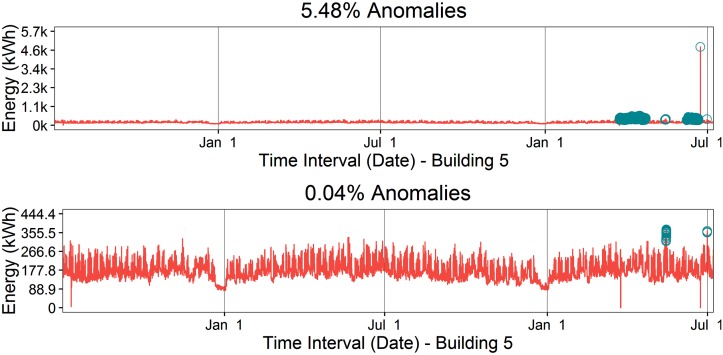
Electricity consumption anomaly cleaning.Building 5(top) raw electricity consumption data (5.48% anomalies) and (bottom) cleaned electricity consumption data (0.04% anomalies).